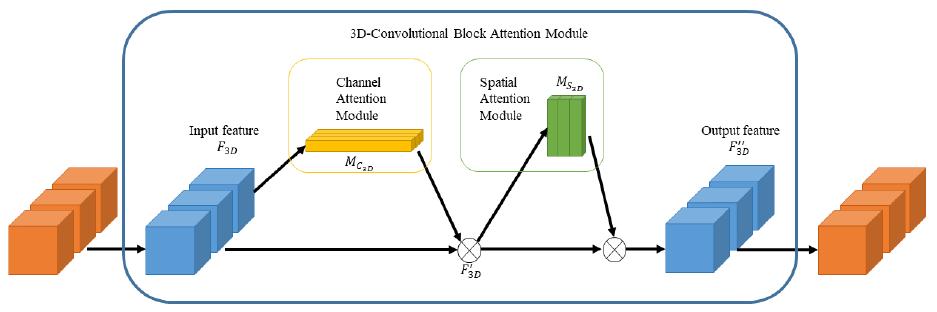
Figure 3. The structure of 3D-CBAM.